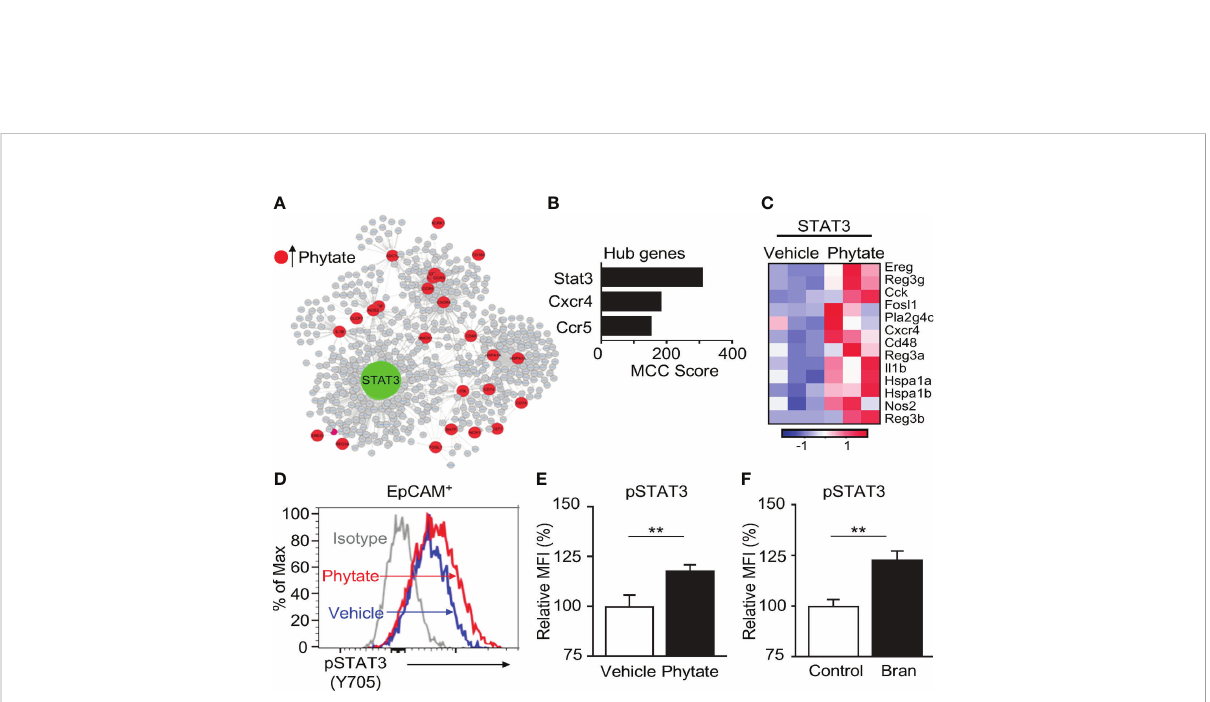
FIGURE 5 Epithelial STAT3 activation in the intestine is induced by phytate. (A) Interaction network of phytate-induced IEC defense genes. (B) Top hub genes in (A) . (C) Heatmap of relative mRNA expression of IEC STAT3-target genes upregulated in phytate-treated. (D) Representative fl ow cytometry plots from IECs of vehicle- or 2% phytate-treated mice, gated on live EpCAM + cells. (E, F) Mean Fluorescence Intensity (MFI) of pSTAT3 (Y705), normalized to vehicle (E) or control (F) . Data are representative of 2-3 independent experiments. n=4 per group. Results are mean ± SEM. ** p <